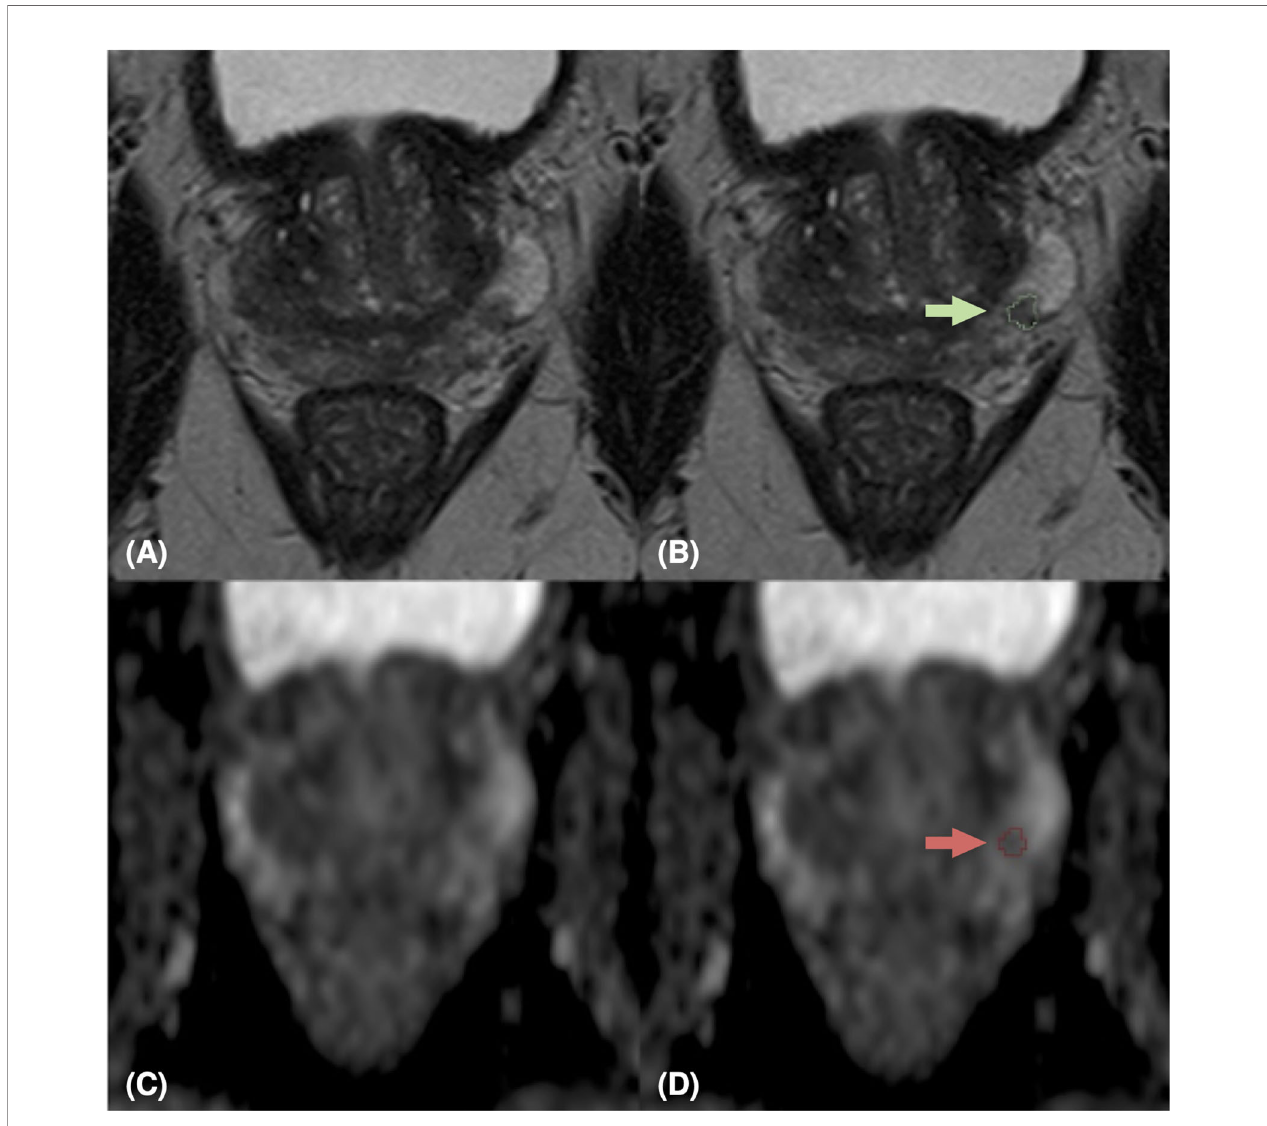
FIGURE 2 | MpMRI of a 65-years old patient with indeterminate mpMRI result (PI-RADS=3), PSA=5.49 ng/ml, GS=3+4 (ISUP 2). MRI zoomed images containing the target lesion, respectively axial T2-weighted image (A) , ADC map (C) , and their relative lesion segmentations (B, D) . The green (B) and red (D) arrows point out the segmented lesion in T2 and ADC images,